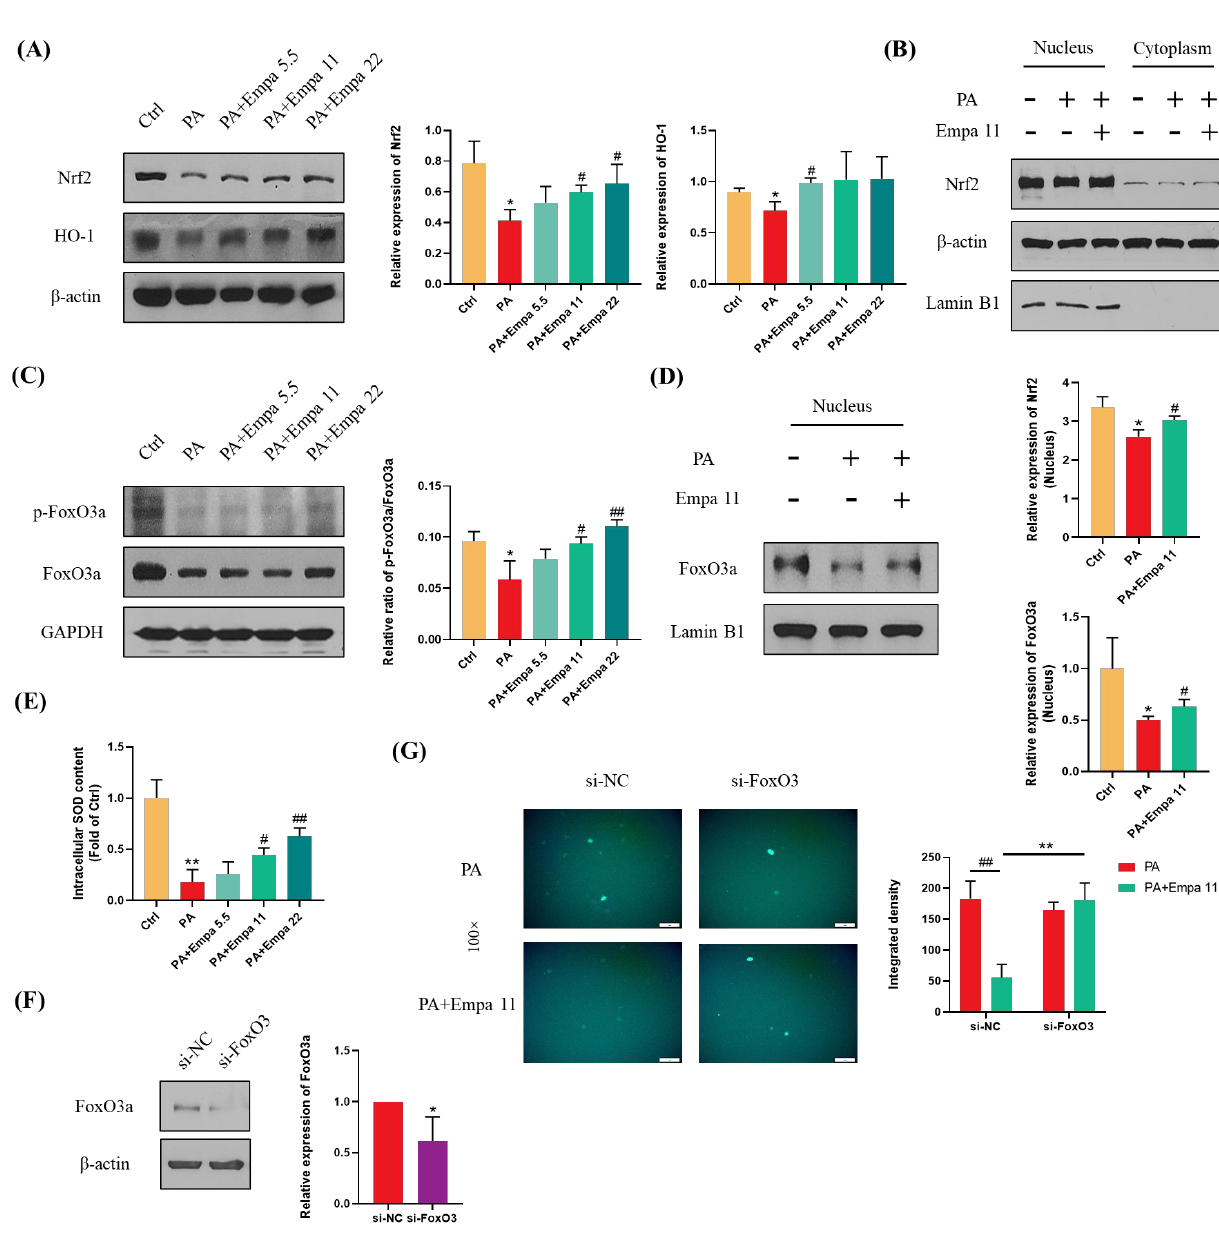
Figure 4. Empa enhanced the cellular antioxidant level of LO2 cells mediated by Nrf2/HO-1 and FoxO3a/SOD pathways. ( A ) Empa increased intracellular Nrf2 and HO-1 protein levels in LO2 cells. ( B ) Empa increased Nrf2 protein level in the nucleus of LO2 cells. ( C ) Empa improved intracellular p -FoxO3a protein level impaired by PA (0.5 mM) in LO2 cells. ( D ) Empa promoted FoxO3a expression in the nucleus of LO2 cells. ( E ) Empa improved intracellular total SOD level in LO2 cells. ( F ) FoxO3 knockdown treatment significantly reduced the protein level of FoxO3a in LO2 cells. ( G ) FoxO3 knockdown treatment abolished the improvement of Empa on ROS generation in PA-treated LO2 cells. All data are expressed as mean ± SD ( n = 3). ( A-E ) * p < 0.05 and ** p < 0.01 versus Ctrl; # p < 0.05, and ## p < 0.01 versus PA. ( F - G ) * p < 0.05 and ** p < 0.01 versus si-NC; ## p < 0.01 versus PA. Ctrl, PA-untreated normal control group; PA, PA-treated control group; PA + Empa 5.5-22, PA-treated and Empa-treated (at final concentrations of 5.5-22 μ M) groups. 3.5. Empa Activated AMPKα, GSK3β , and Sirt1 in PA-Treated LO2 Cells, Which Might Be Associated with Nrf2 and FoxO3a Signaling Axes-Mediated Antioxidant System